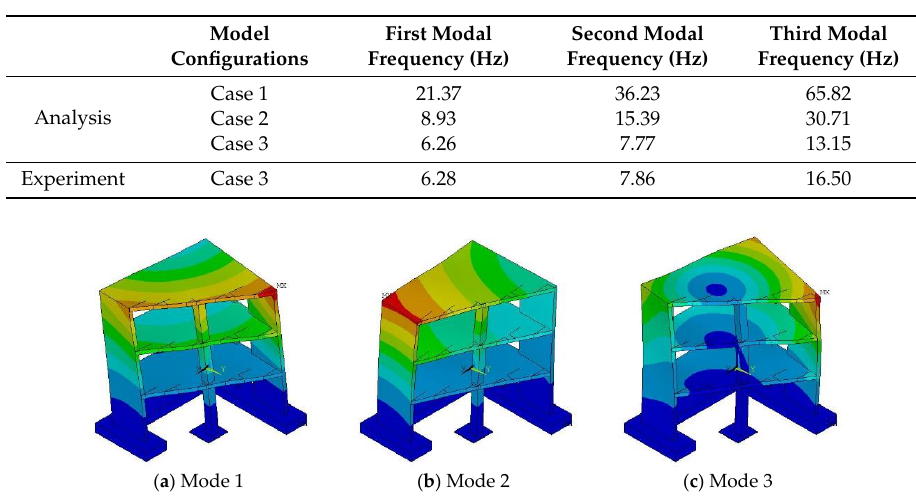
Figure 15. Mode shapes of the SMART 2013 RC structure for the model Case 1.